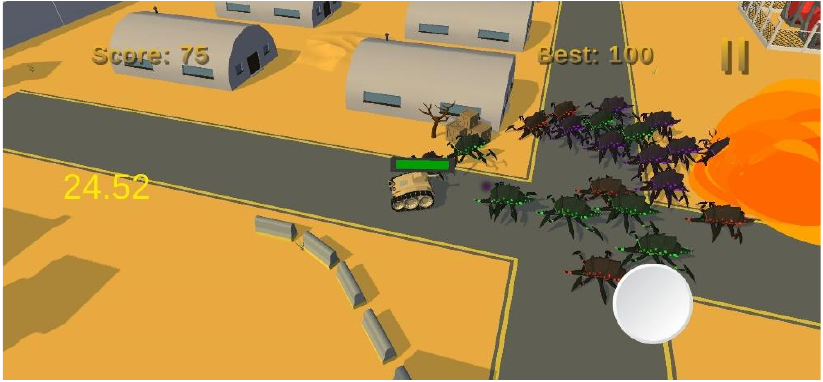
Figure 20. Snapshot after the elimination of 75 enemies in the non-optimized version of the